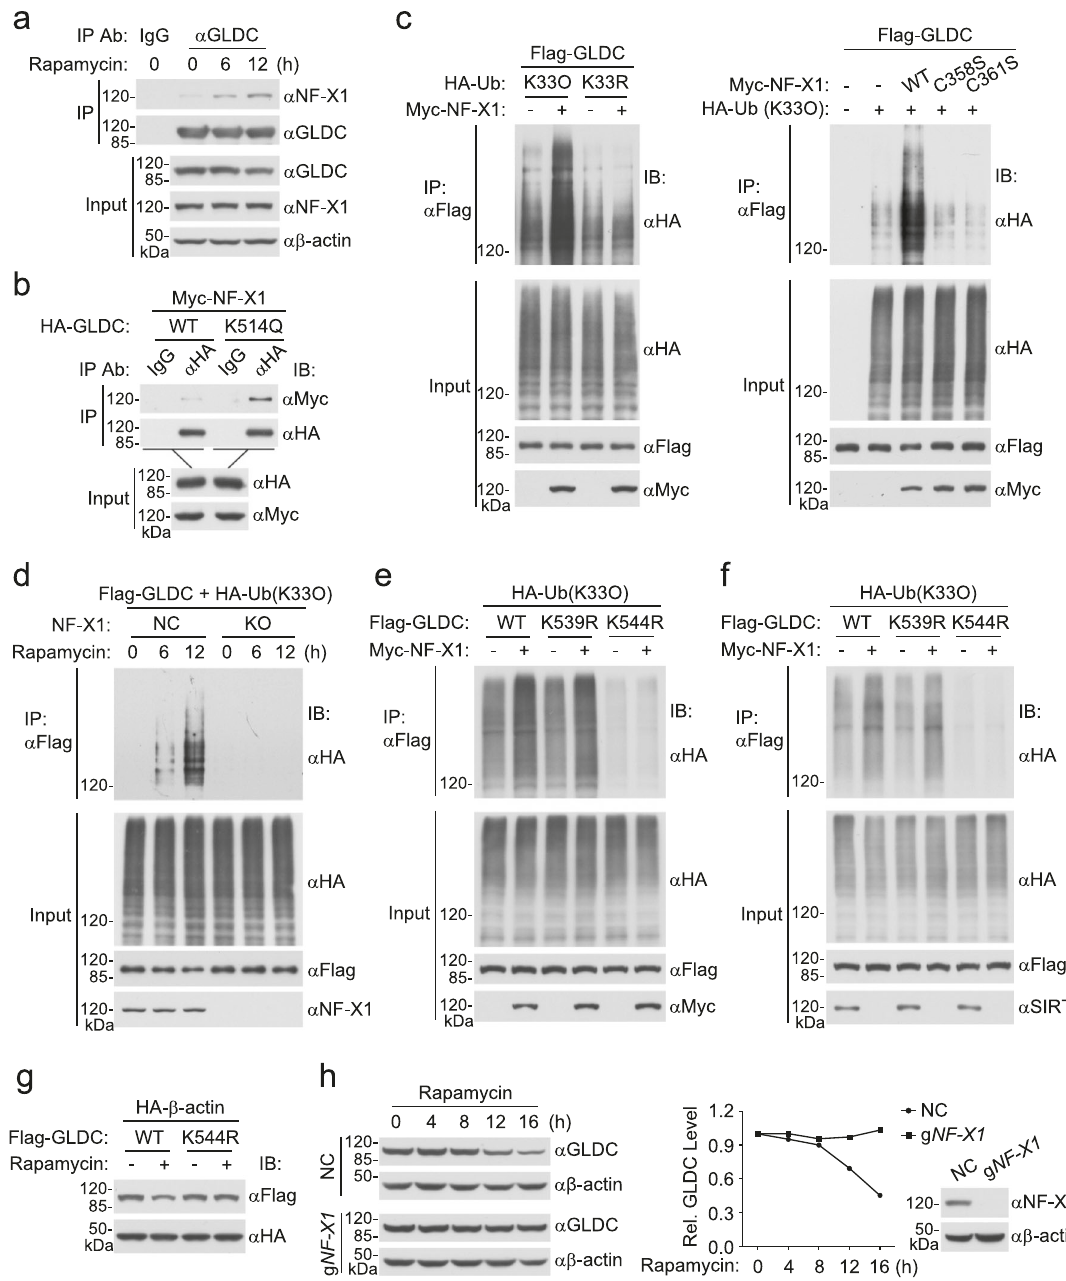
Fig. 6 NF-X1 mediates K33-linked polyubiquitination of GLDC. a Association of GLDC with NF-X1. U251 cells were treated with DMSO or Rapamycin (50 nM) for the indicated times before co-immunoprecipitation and immunoblotting analysis with the indicated antibodies. b GLDC K514Q interacts with NF- X1 better than wild-type GLDC. HEK293 cells were transfected with the indicated plasmids for 24 h before co-immunoprecipitation and immunoblotting analysis with the indicated antibodies. c NF-X1 promotes K33-linked polyubiquitination of GLDC. HEK293 cells were transfected with the indicated plasmids for 24 h before co-immunoprecipitation and immunoblotting analysis with the indicated antibodies. d NF-X1 de fi ciency impairs Rapamycin- induced K33-linked polyubiquitination of GLDC. Control or NF-X1-de fi cient HEK293 cells were transfected with the indicated plasmids for 12 h and then treated with DMSO or Rapamycin (50 nM) for the indicated times before co-immunoprecipitation and immunoblotting analysis with the indicated antibodies. e NF-X1 increases K33-linked polyubiquitination of wild-type GLDC and GLDC K539R but not GLDC K544R . HEK293 cells were transfected with the indicated plasmids for 24 h before co-immunoprecipitation and immunoblotting analysis with the indicated antibodies. f SIRT3 de fi ciency increases K33-linked polyubiquitination of wild-type GLDC and GLDC K539R but not GLDC K544R . Control or SIRT3-de fi cient HEK293 cells were transfected with the indicated plasmids for 24 h before co-immunoprecipitation and immunoblotting analysis with the indicated antibodies. g Rapamycin induces downregulation of wild-type GLDC but not GLDC K544R . HEK293 cells were transfected with the indicated plasmids for 12 h and then treated with DMSO or Rapamycin (50 nM) for 16 h before immunoblotting analysis with the indicated antibodies. h NF-X1 de fi ciency inhibits Rapamycin-induced degradation of GLDC. Control or NF-X1-de fi cient U251 cells were untreated or treated with Rapamycin (50 nM) for the indicated times before immunoblotting analysis. The GLDC band intensities relative to the corresponding β -actin bands are shown in the histograph. Source data are provided as a Source data fi le.